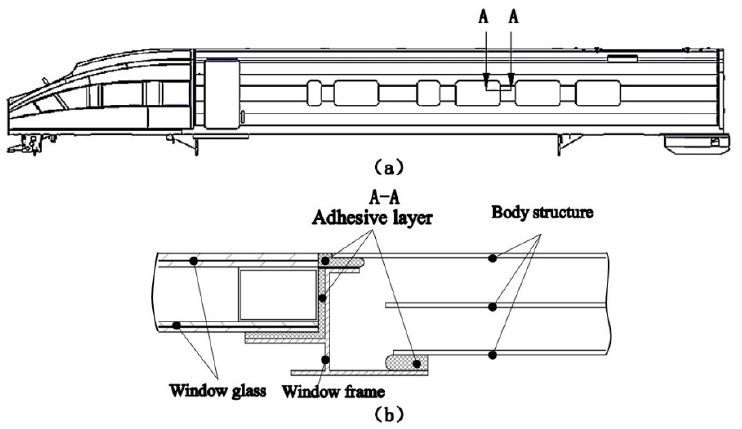
Figure 1. ( a ) Schematic diagram of the high-speed train, ( b ) schematic diagram of side window adhesive structure.